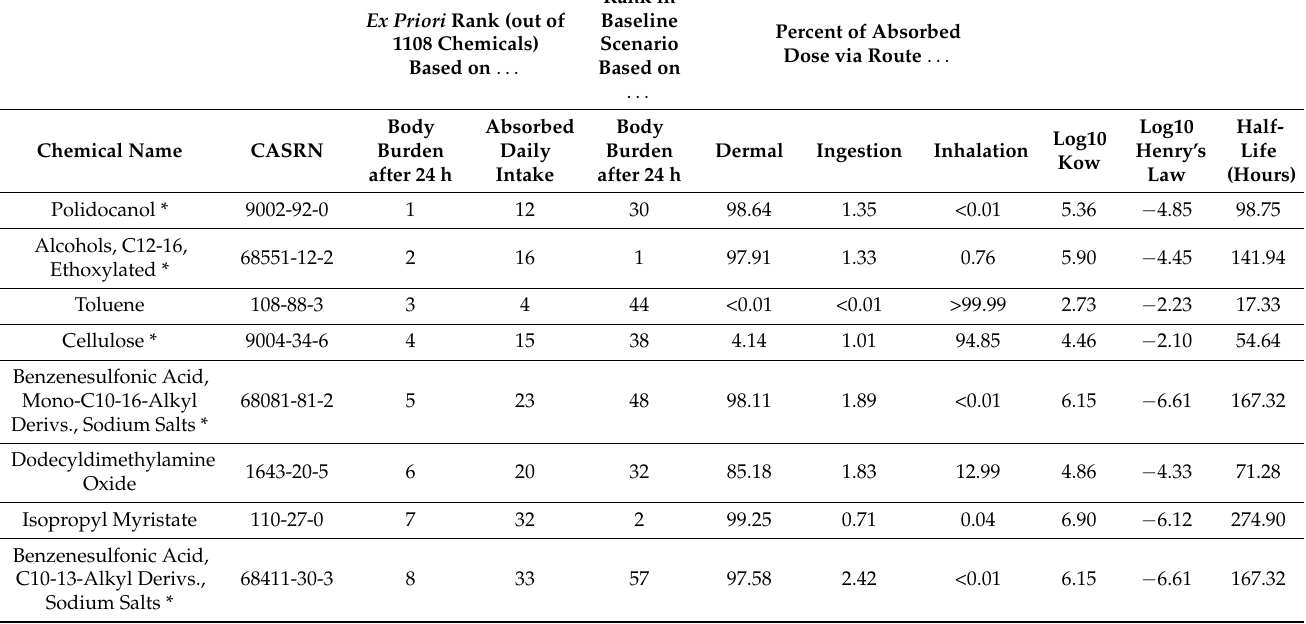
Table 3. For the pandemic scenario: Subset of chemical rankings (top 20 of 1108), with rankings by exposure route. All other weights (route and product category) are set to 1, and all parameters take their default values. ((*) = polymers and/or mixtures; does not necessarily apply to each component of a mixture and does not apply to a single sub-unit of a